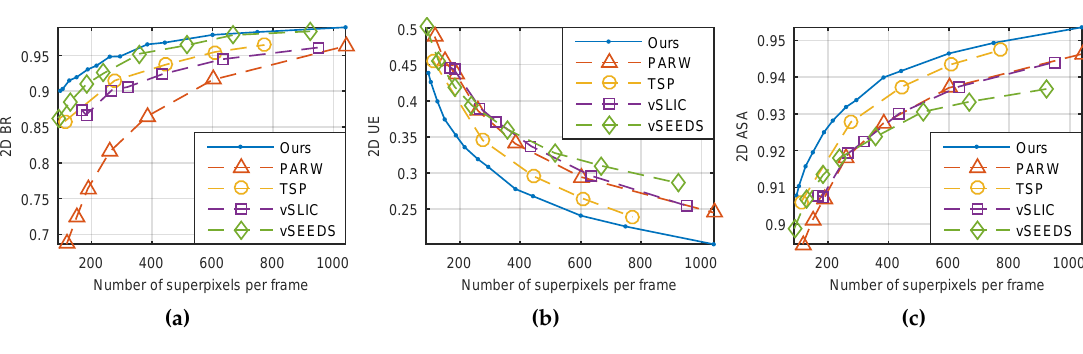
Figure 5. Results of 2D metrics. ( a ) 2D BR; ( b ) 2D UE; ( c ) 2D ASA.